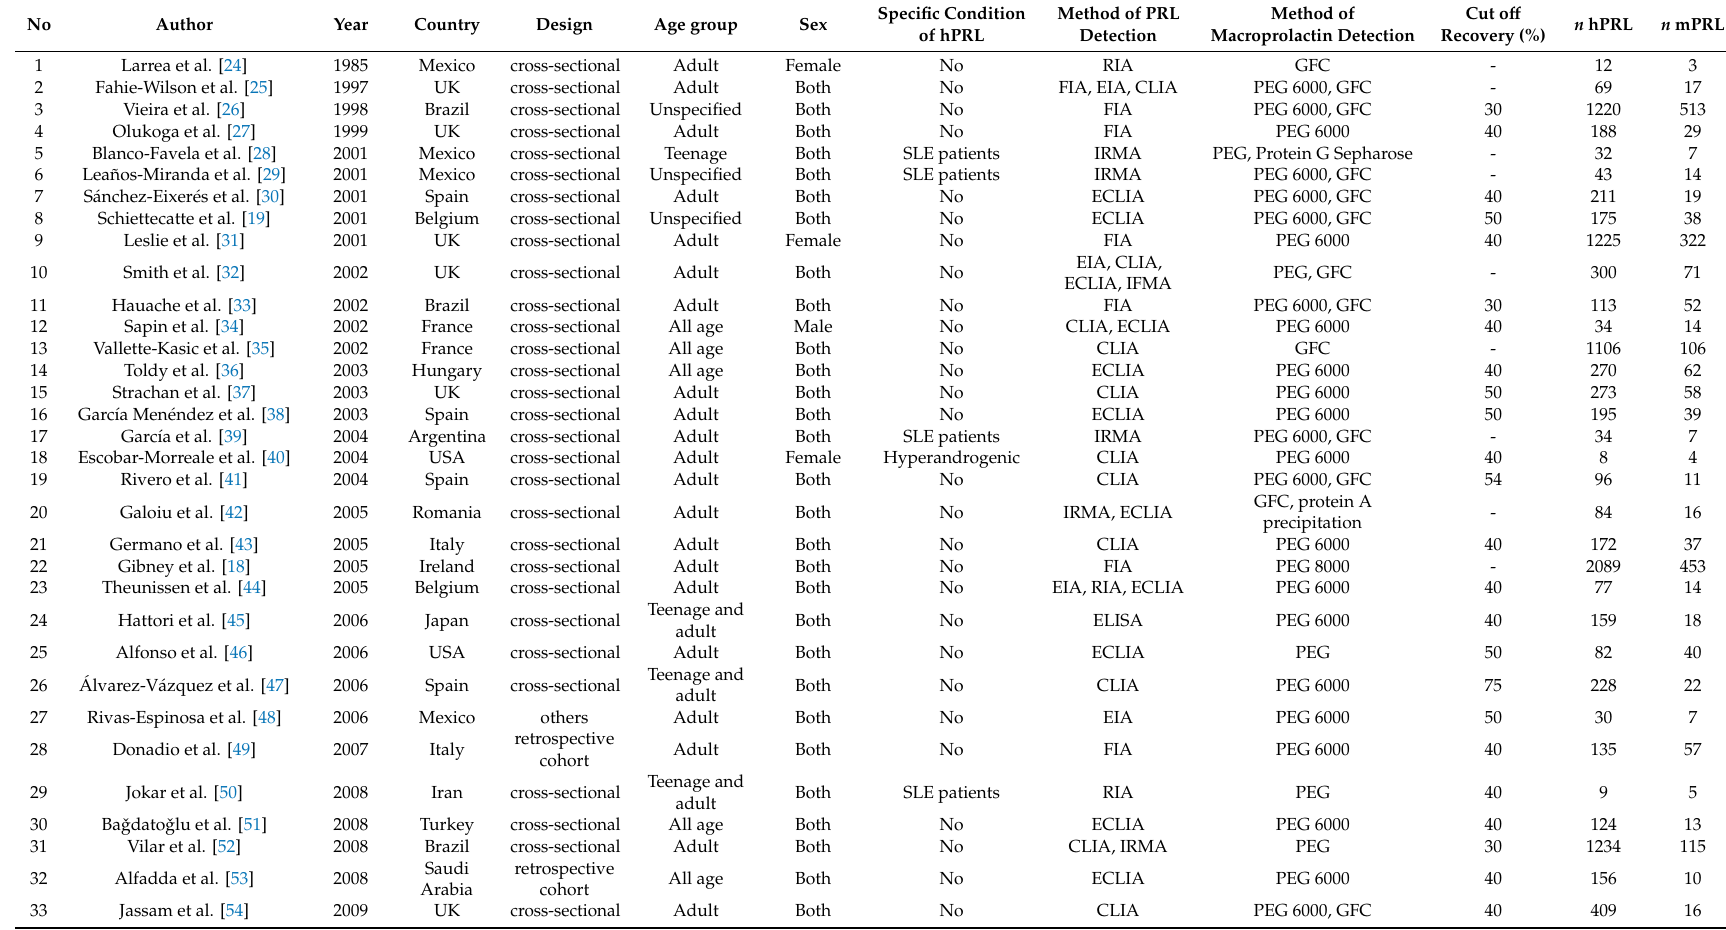
Table 1. Details of studies on the prevalence of macroprolactinemia among patients with hyperprolactinemia, sorted by